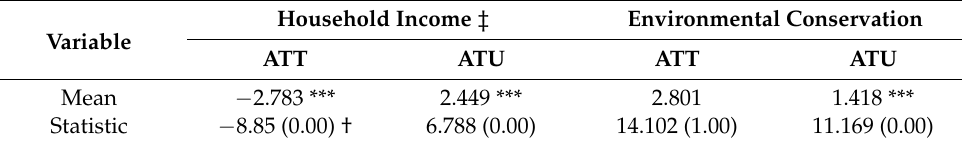
Table 8. Average treatment effects for certified and non-certified coffee farmers.